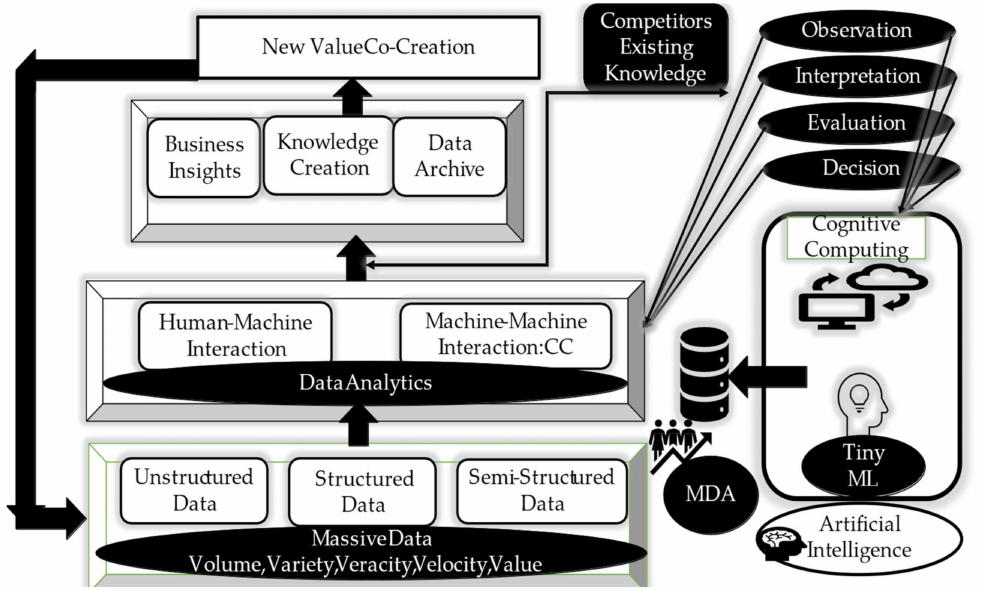
Figure 13. Linking CC, MDA, and AI for healthcare value